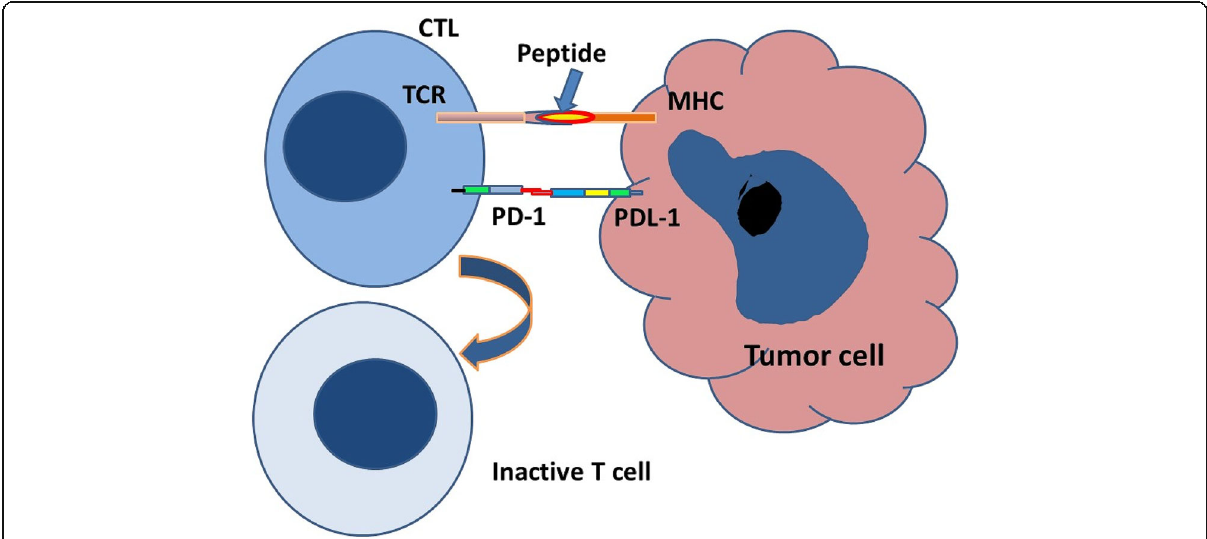
Fig. 5 Engagement of PD-L1 on the tumor cell with PD-1 on the ATC along with co-stimulation provided by T-cell receptor and MHC results in inactivation of the lymphocyte